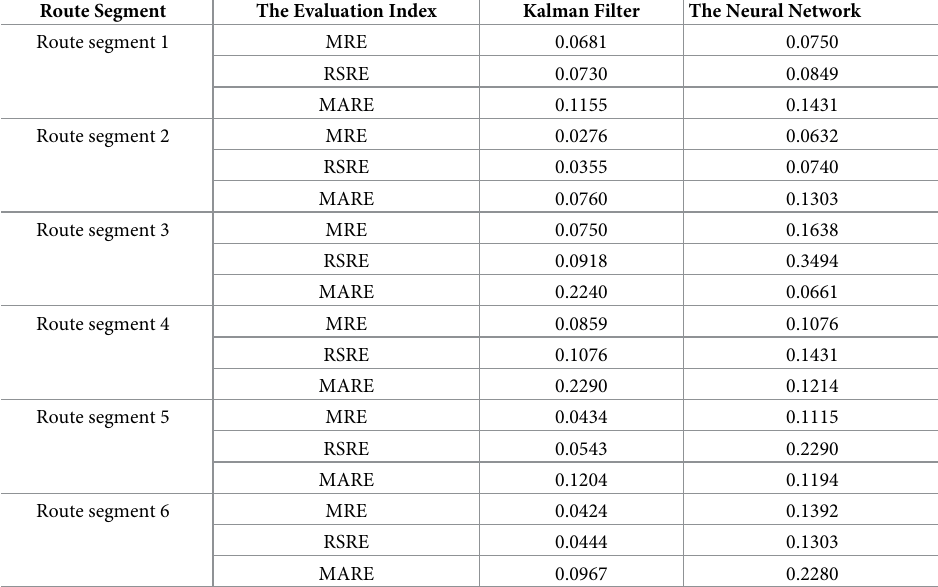
Table 4. Prediction error of travel time between